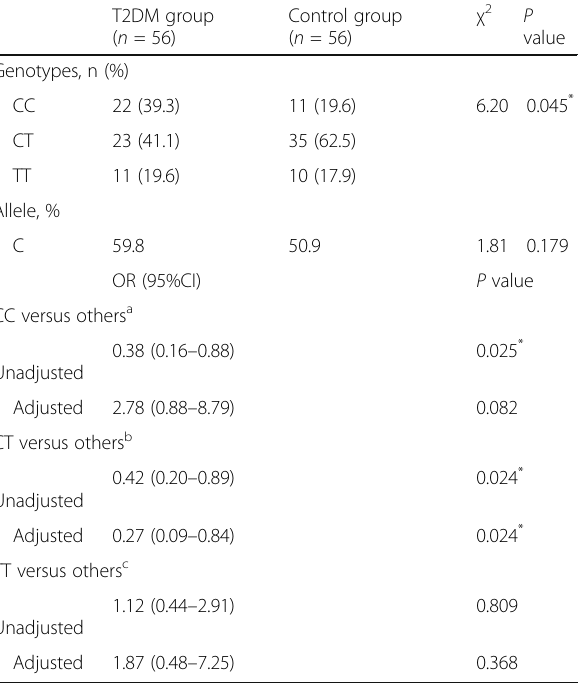
Table 2 Genotypes distributions of ATM rs189037 and the association with T2DM ( n = 160)